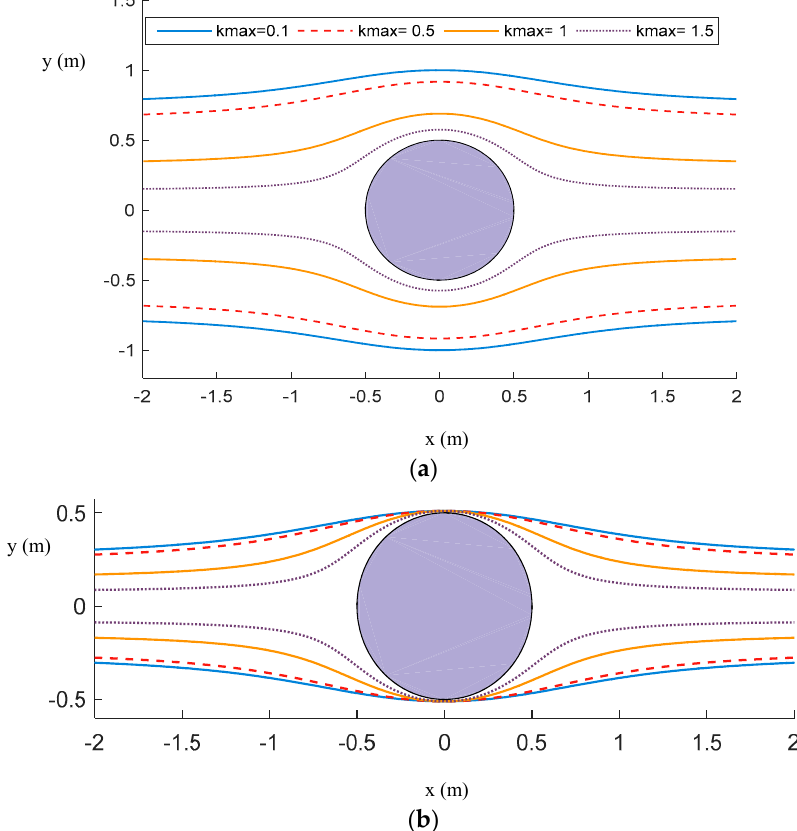
Figure 7. The concept of sharp turn streamline paths to circumvent a circular obstacle with the center placed at the origin in the x - y plane. ( a ) Streamline paths with different maximum curvatures. The curvature of the streamline is larger as it is closer to the circle. ( b ) Feasible paths compatible with different curvature constraints are pulled back to graze the obstacle border.